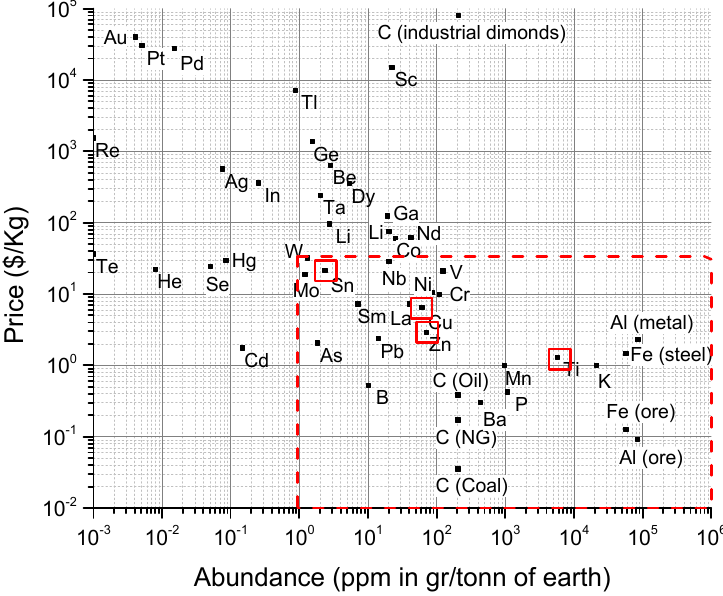
Figure 1. Abundance and price of elements with Ti, Ni, Sn, and Cu marked data from Hurd et al. [11].